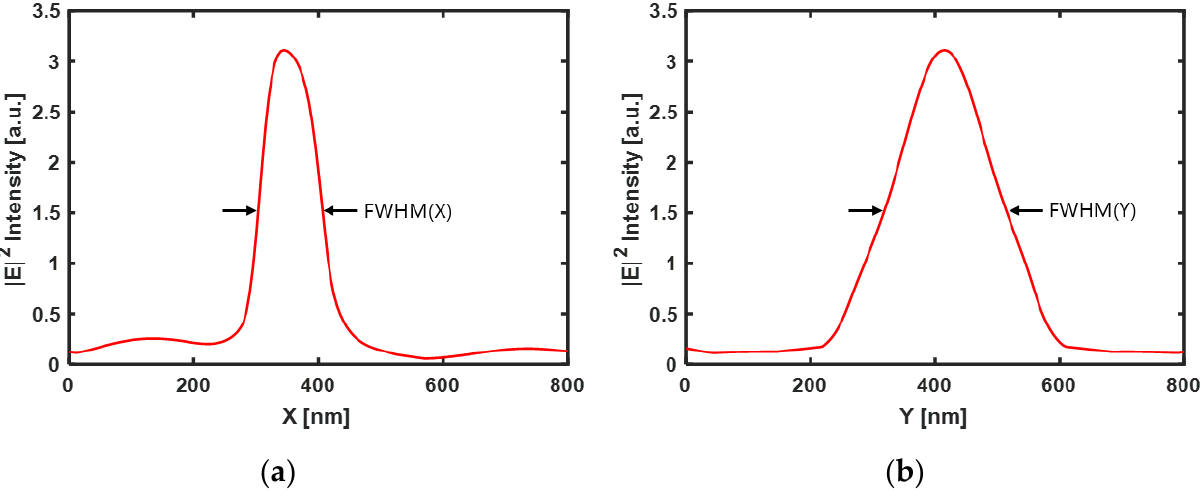
Figure 7. Maximum |𝑬| (cid:2870) intensity profile at the cross-sections of the ridge-type nanoaperture with Figure 7. Maximum | E | 2 intensity profile at the cross-sections of the ridge-type nanoaperture with Au NPs array deposited media at the bottom surface of the ZnS-SiO 2 layer. The spot size, calculated Au NPs array deposited media at the bottom surface of the ZnS-SiO 2 layer . The spot size, calculated at FWHM, is ( a ) 100 nm × ( b ) 185 at FWHM, is ( a ) 100 nm × ( b ) 185 nm.